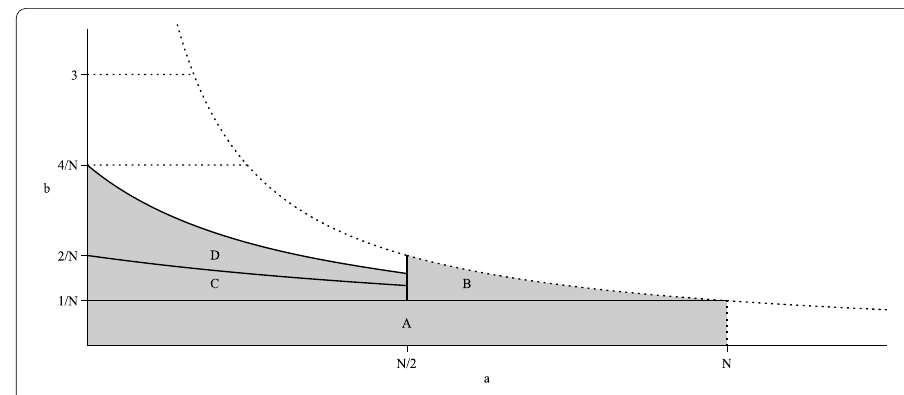
Figure 1 The Gabor frame set. The figure shows the following regions: B as in Proposition 1.1(iii), and D as in Theorem 1.2. The region A corresponds to the case where the frame operator is a multiplication operator,